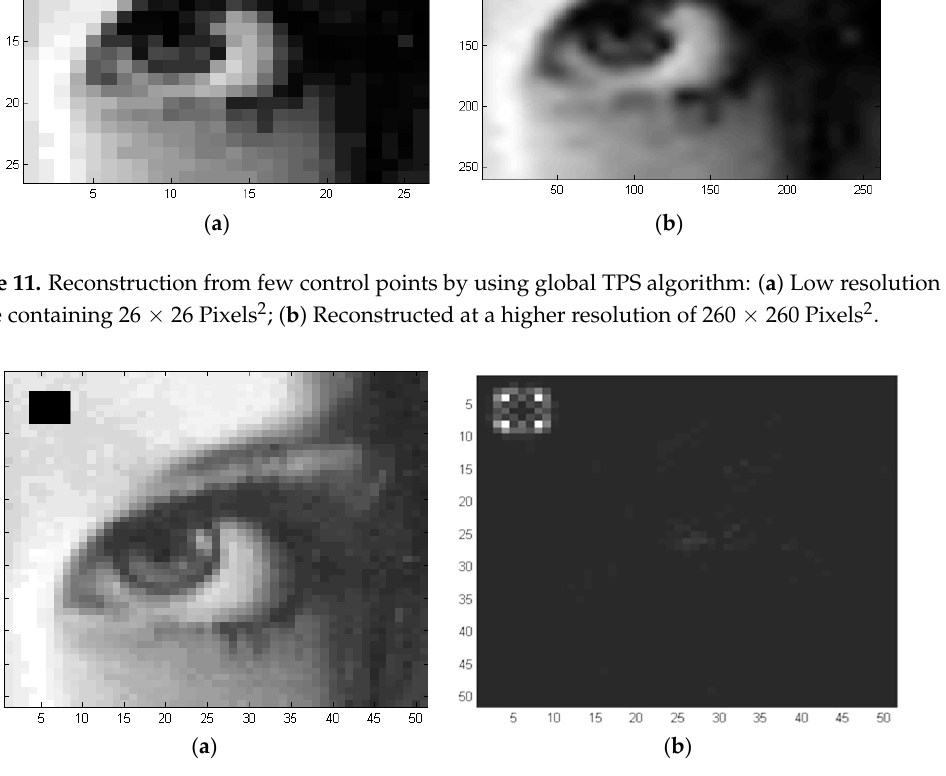
( b ) Figure 13. Reconstruction of a poor image: ( a ) Defected and distorted image; ( b ) Automatic denoising and reconstruction. We investigate the windowing techniques for a 51 × 51 Pixel 2 image. Figure 14a is divided into 5 × 5 square windows. The modified TPS algorithm is then implemented at the local coordinates of each window with the goal to increase the overall image resolution. The overall image resolution has increased from 100 × 100 Pixel 2 to 250 × 250 Pixel 2 as shown in Figure 14b,c, respectively. A quick comparison between global and local modified TPS methods showed that the number of computations required to inverse H matrix of a 26 × 26 Pixel 2 are 198, 977 and 37,500, respectively; however, the boundaries between the square windows are not smooth, and they become visually sharp when the resolution increases. This is observed in Figure 10b,c. To mitigate such shortcoming, the rest of this section studies the application of warping by using the procedures that we suggested in Sections 2.4.3 and 2.4.4.